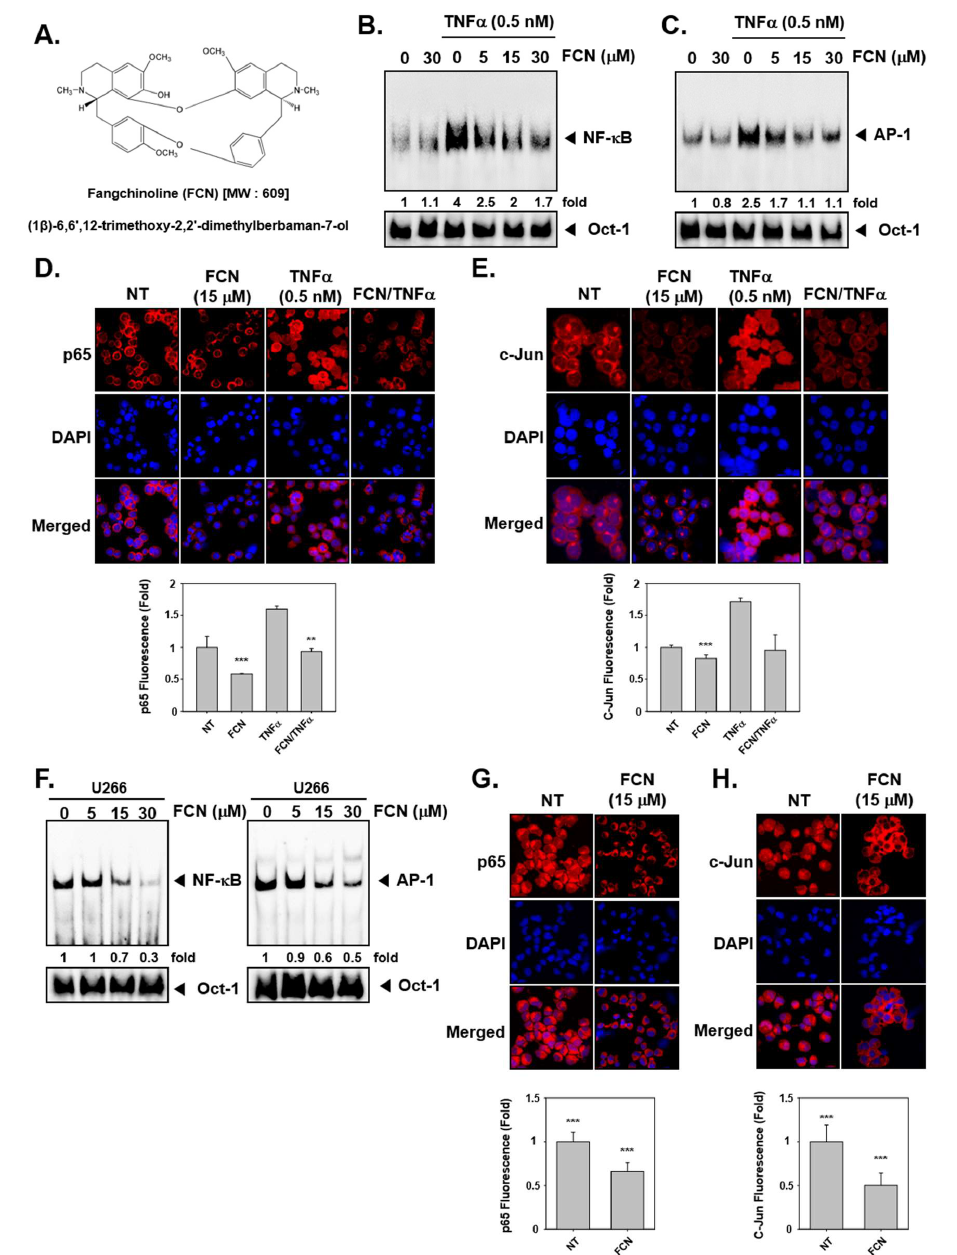
Figure 1. Fangchinoline (FCN) affects the activation of oncogenic transcription factors. ( A ) The chemical structure of FCN. ( B , C ) FCN was added in different concentrations to KBM5 cells. After 2 h of treatment, 0.5 nM of TNFα was added for 15 min. Nuclear extracts (NE) were prepared for electrophoretic mobility shift assay (EMSA) assay to evaluate Nuclear factor-κB (NF-κB) and activator protein-1 (AP-1) expression. Oct-1 was used as loading control. ( D , E ) KBM5 cells were treated as